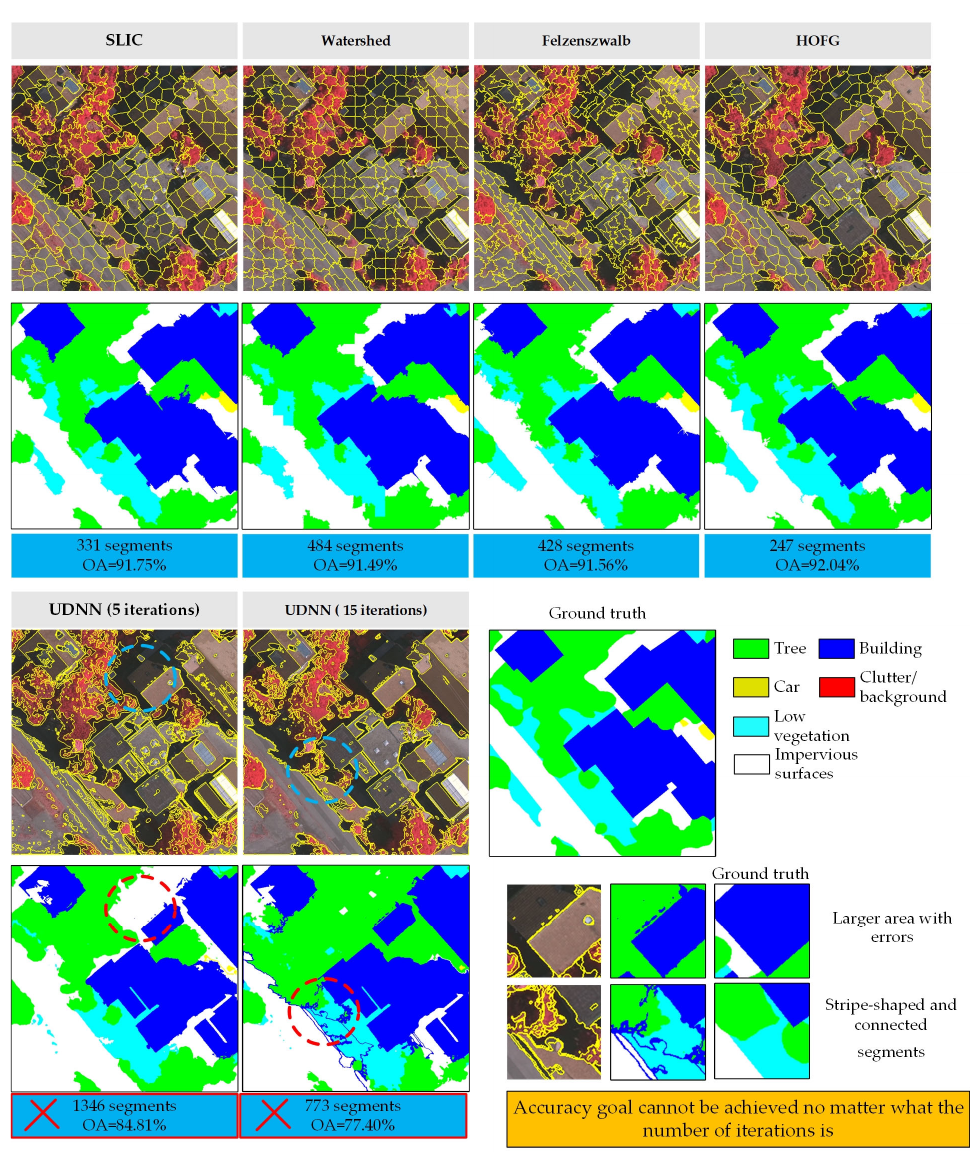
Figure 8. Segmentation results of the five methods.